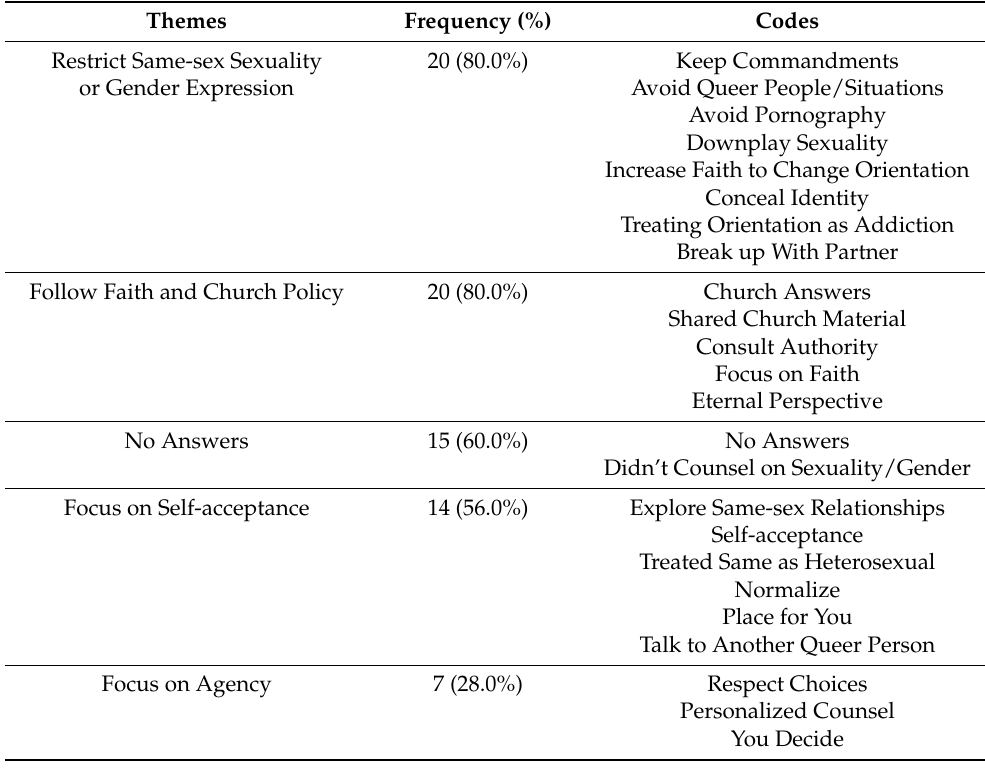
Table 2. Counsel given: themes, frequencies, and